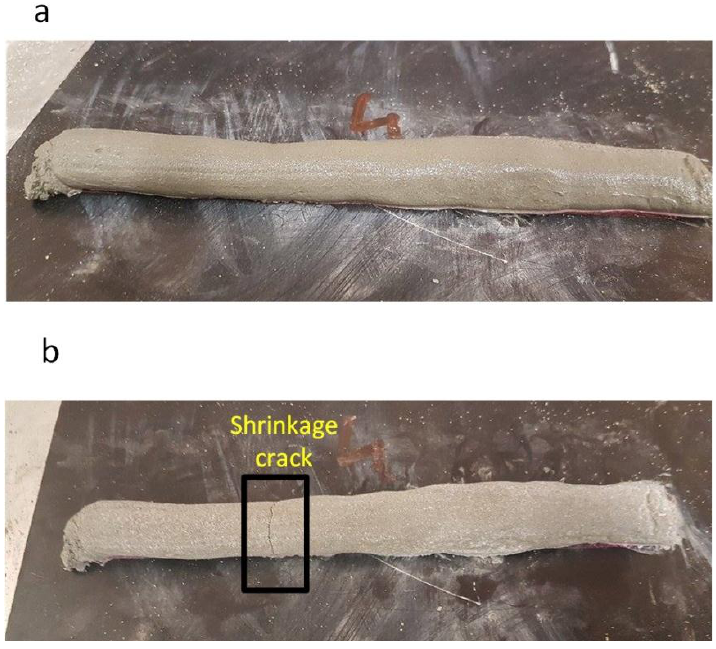
Figure 13. ( a ) The printed part immediately after printing; ( b ) the printed part after one-day